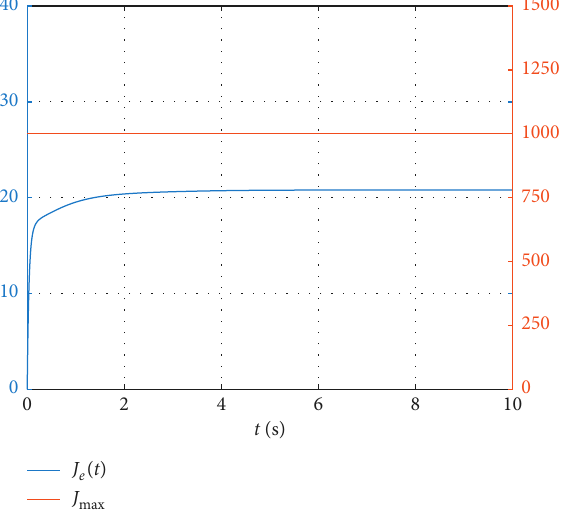
Figure 5: Practical energy consumption and the limited